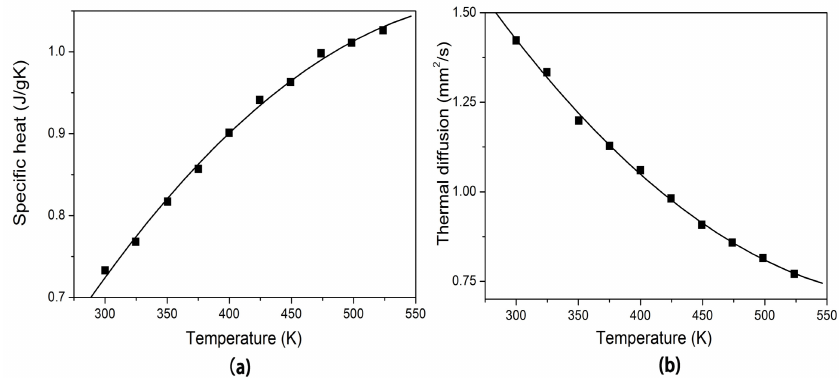
Figure 3. Specific heat and thermal diffusivity versus temperature curve of Er:Yb:GMB.